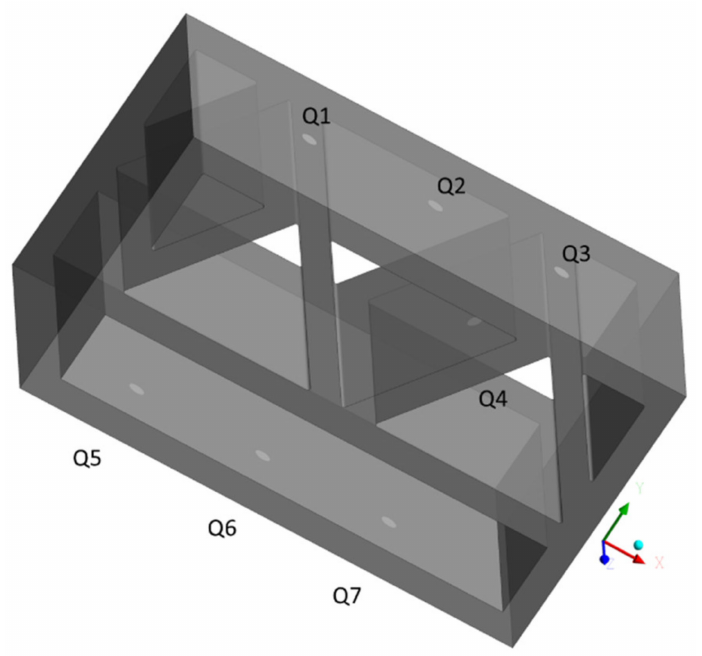
Figure 14. Numerical heat flux sensors’